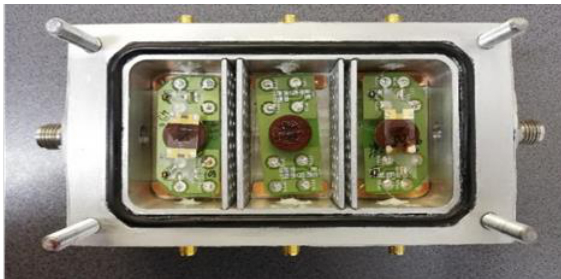
Figure 1. Surface Acoustic Wave (SAW)sensors in the test chamber.